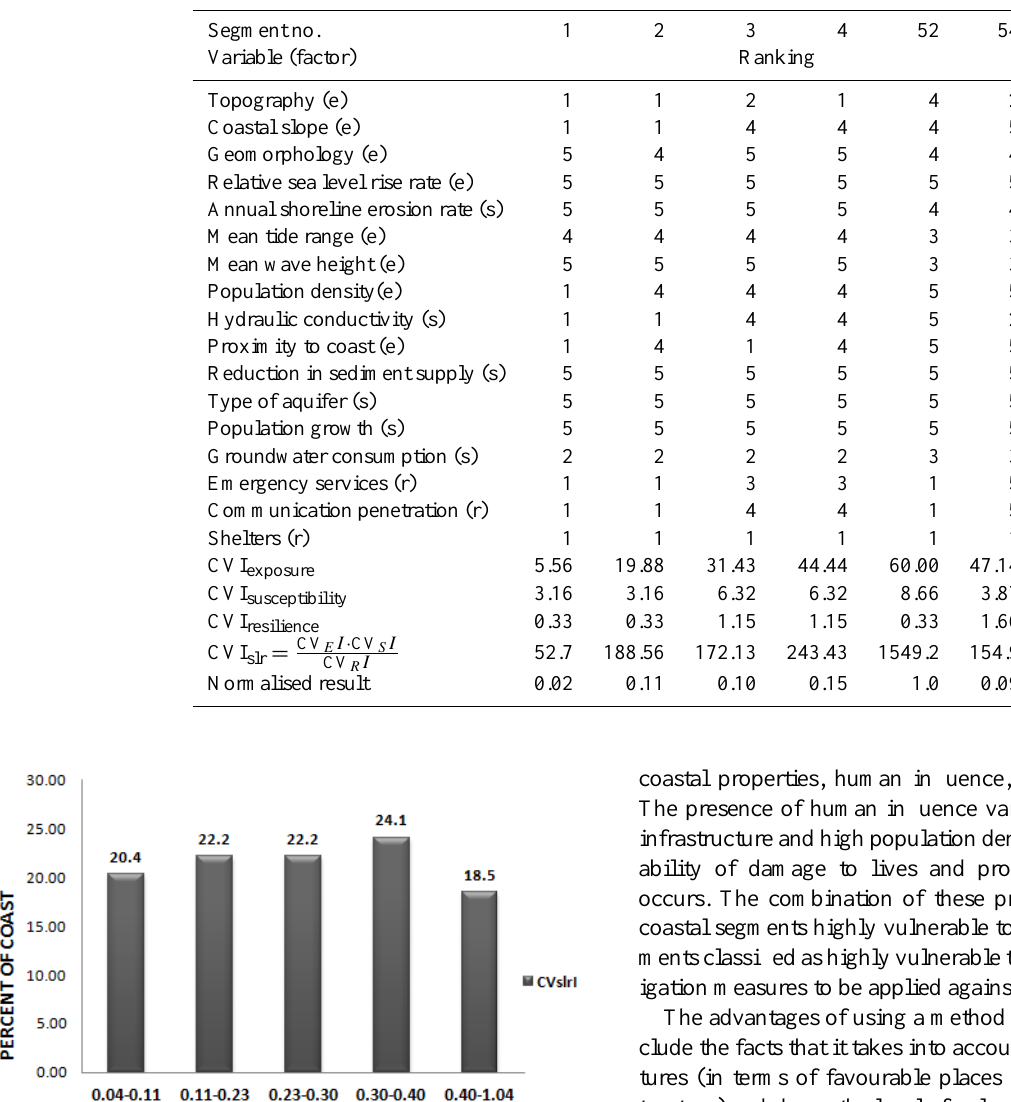
Table 5. Ranking per indicator and CVI results for six segments.